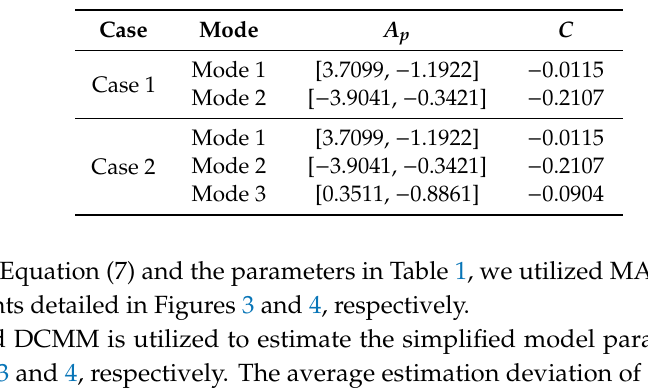
Table 1. The true values of the simplified model parameters of case 1 and